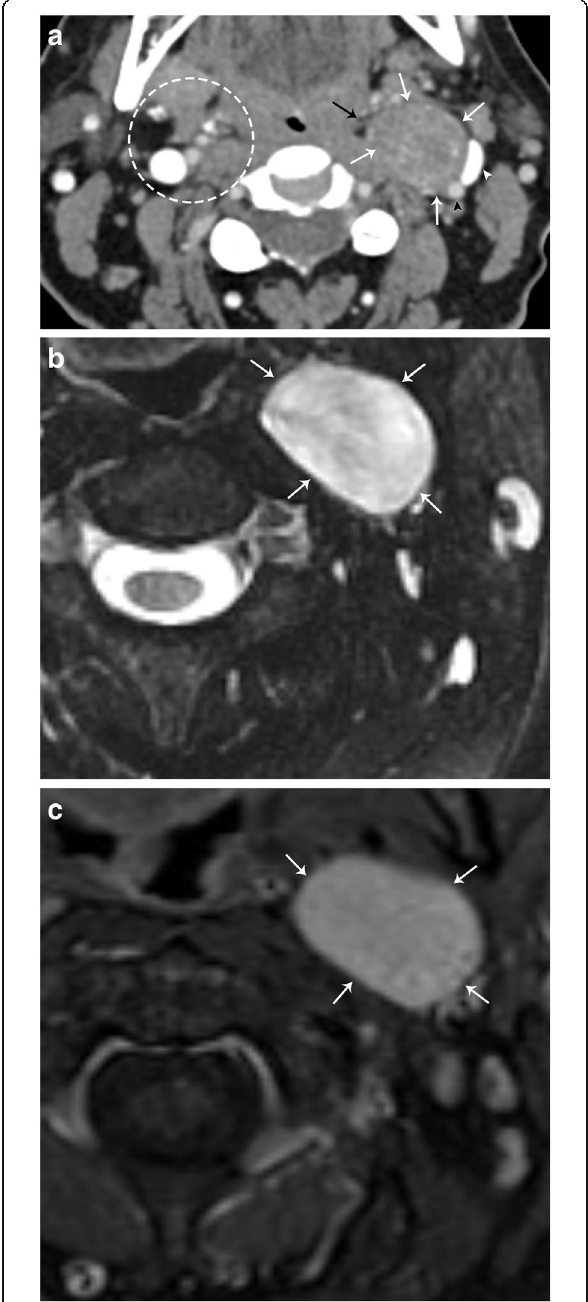
Fig. 9 Sympathetic plexus schwannoma. a Axial CT image demonstrates a well-circumscribed mass (white arrows) that laterally displaces the left internal carotid artery (black arrowhead) and left internal jugular vein (white arrowhead). The left parapharyngeal fat is medially displaced (black arrow). Note the normal configuration of the right carotid space and parapharyngeal fat (dotted circle). b Axial T2 fat-suppressed MR image demonstrates homogenous hyperintensity of this mass (white arrows). c Axial T1 post-contrast fat-saturated MR image demonstrates homogenous enhancement of the lesion. Note the anteromedial location of the lesion relative to the carotid vessels, indicating sympathetic plexus origin